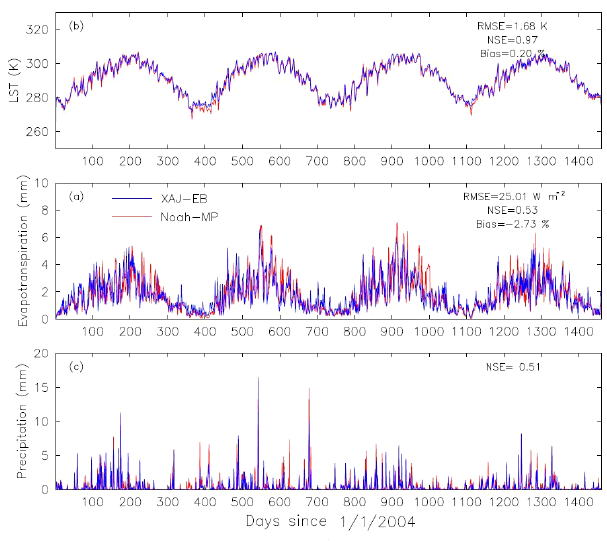
Figure 10. Comparison between XAJ and XAJ-EB-modeled daily runoff (a) and soil moisture (b) for the year 2007; soil moisture is expressed as equivalent water depth (soil depth ∗ volumetric soil moisture) as defined by the XAJ model.